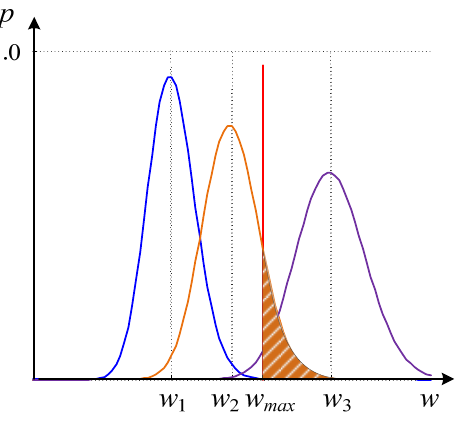
Figure 8. The probability density function for bit error